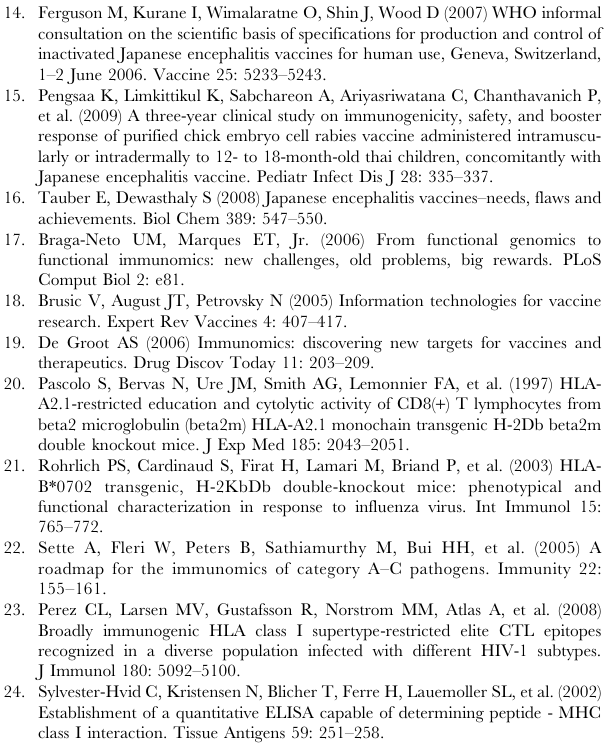
Table S1 Peptides analyzed and immunization pools. (DOC) Table S2 Binding affinities for YFV and DFV peptides. (DOC)